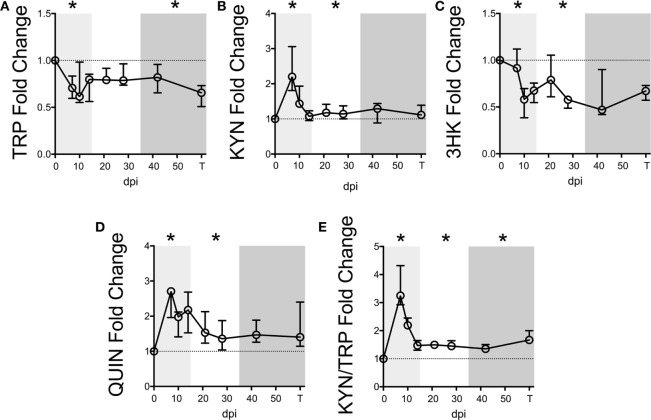
Longitudinal kynurenine pathway metabolites in plasma during SIV infection of pigtailed macaques. Seven pigtailed macaques were followed longitudinally, with three plasma samples taken prior to infection and seven samples taken postinfection at days 7, 10, 14, 21, 28, 42, and terminally (approximately 84 dpi). Plasma samples were analyzed for levels of (A) TRP, (B) KYN, (C) 3HK, (D) QUIN, and (E) KYN/TRP ratios. Data are represented as median fold change over the average of the preinfection samples for each animal. Error bars represent interquartile ranges. Dotted lines represent the median of preinfection values. Light gray shading represents the acute phase of infection (0–14 dpi), and dark gray shading represents the chronic phase of infection (≥35 dpi) in our model. Asterisks (*) indicate whether the peak for each animal during acute infection or median values for each animal during asymptomatic and chronic infection was significantly different (p < 0.05) from respective preinfection values by Wilcoxon signed-rank test followed by Bonferroni correction.